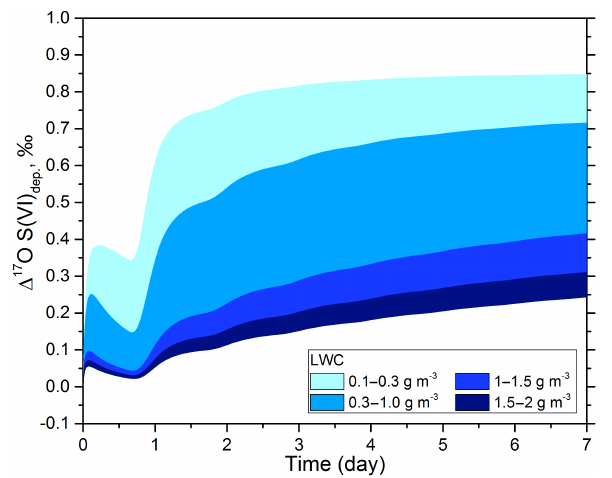
Figure 10. Temporal evolution of (cid:49) 17 O(S ( VI ) ) dep . at different val- ues of liquid water content. Other initial critical parameters are set as follows: [Fe ( III ) ] = 0.5µM and [SO 2 ] 0 = 1.5ppmv.